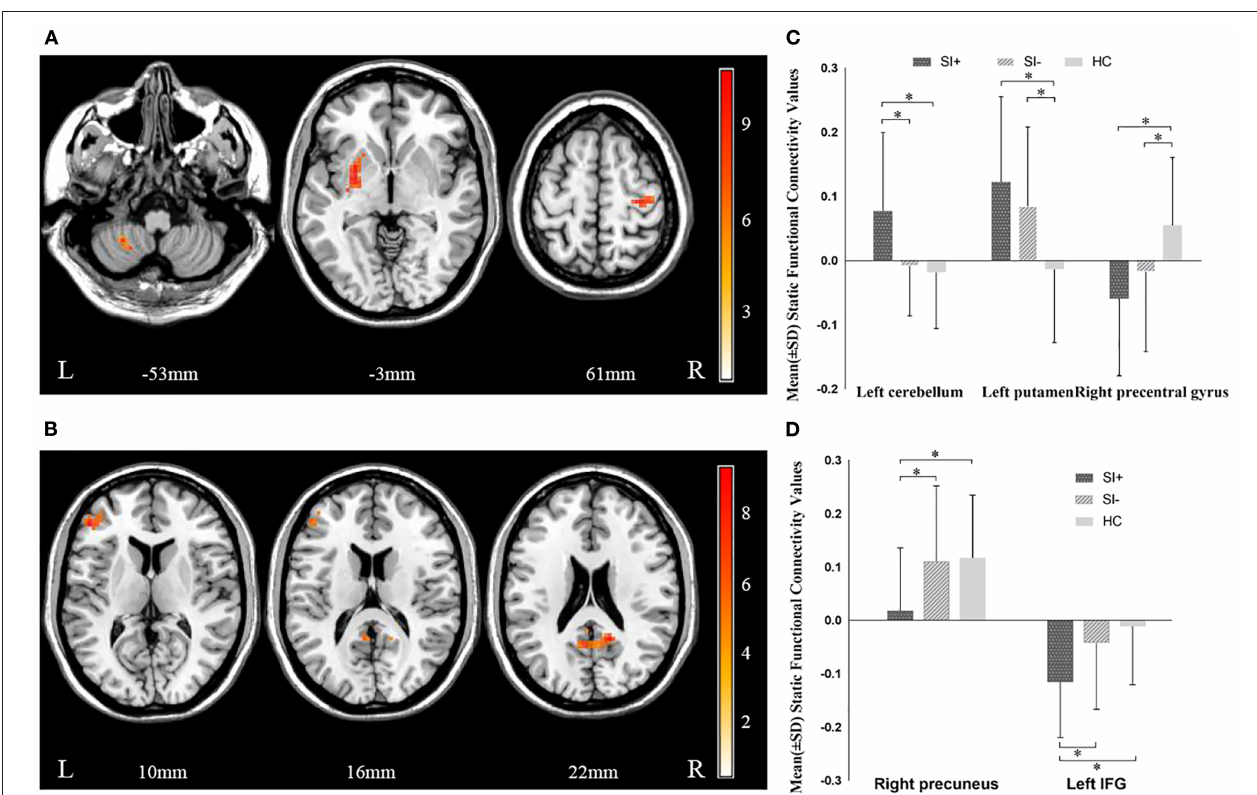
FIGURE 1 | Significant differences in static functional connectivity (sFC) of (A) left habenula and (B) right habenula among the major depressive disorder with suicidal ideation (SI + ), MDD without suicidal ideation (SI–), and healthy control (HC) groups. The color bars indicate the F value based on one-way ANOVA. Significant at P < 0.001, corrected by Gaussian random field (GRF) correction. Post hoc analysis in static functional connectivity (sFC) of (C) left habenula and (D) right habenula among the major depressive disorder with suicidal ideation (SI + ), MDD without suicidal ideation (SI–), and healthy control (HC) groups. * P < 0.05, corrected by Bonferroni test. IFG, inferior frontal gyrus.